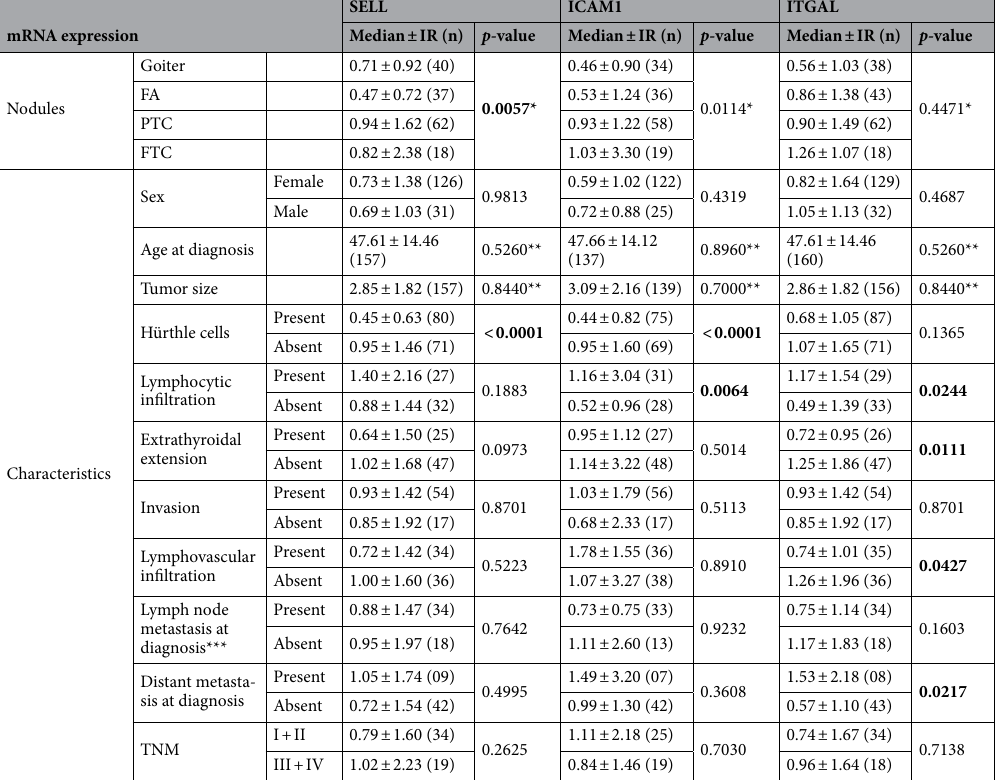
Table 1. SELL, ICAM1 and ITGAL mRNA expression in 191 thyroid nodule patients and clinical features. Mann–Whitney test; *Kruskal–Wallis test; **Spearman correlation. ***Lymph node metastasis at diagnosis analysis only considered PTC cases. IR Interquartile Range; FA Follicular Adenoma; PTC Papillary thyroid cancer; FTC Follicular thyroid cancer. Significant values are in